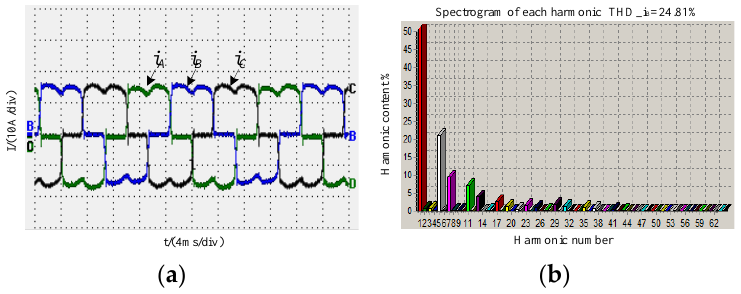
Figure 22. Uncompensated waveforms: ( a ) current of power grid; ( b ) THD of B-phase current.